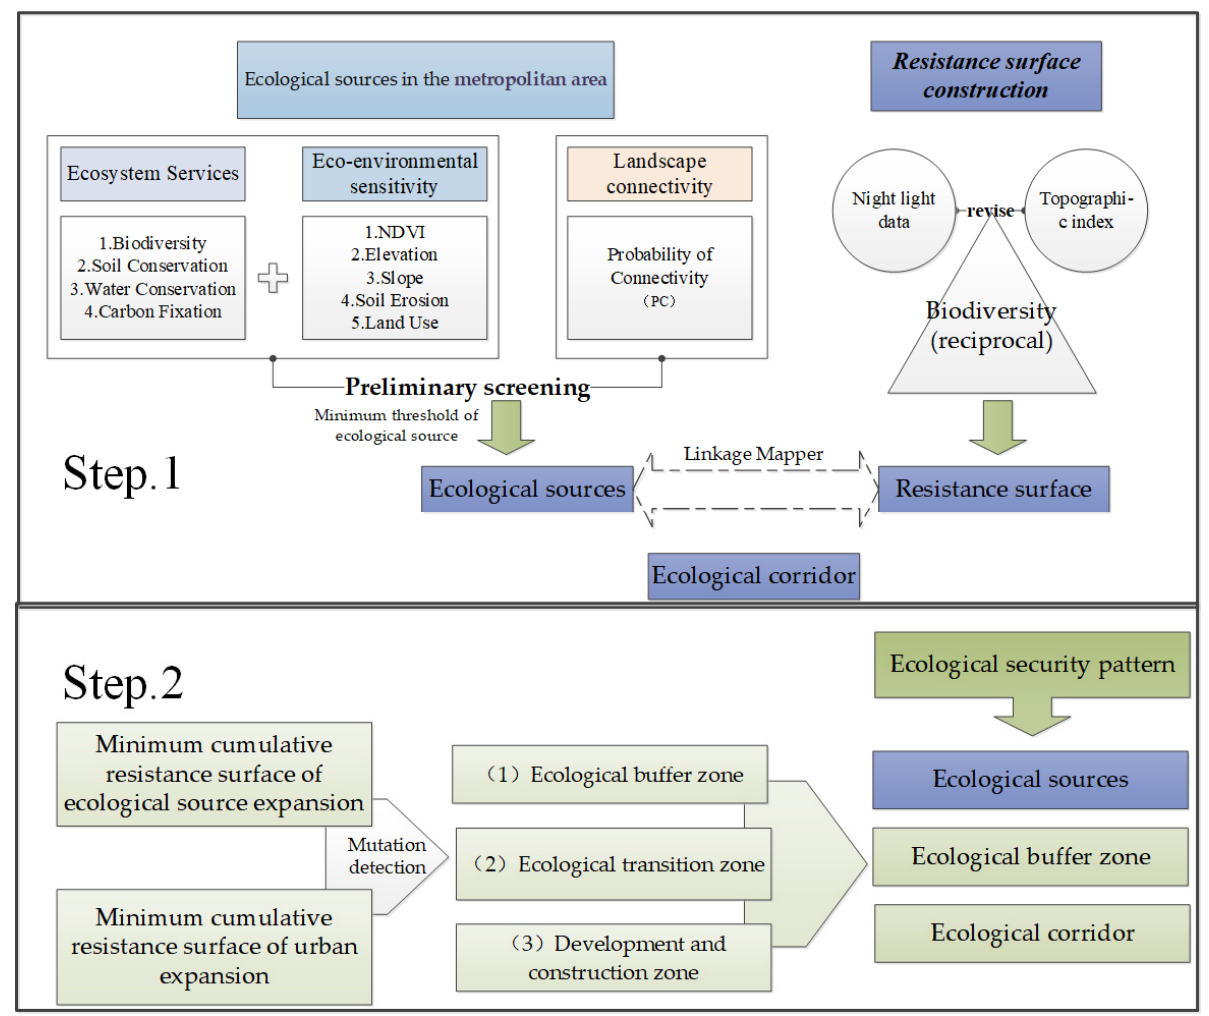
Figure 2. Technology